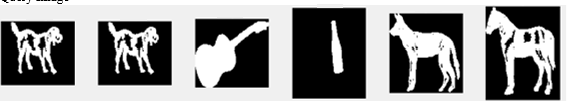
Figure 5. Image2 retievals using Moment Based Features